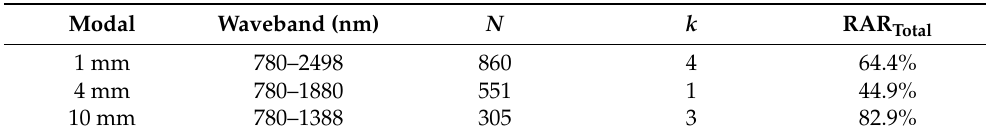
Table 1. Modeling discrimination effects of kNN models of three measurement modals based on desaturated wavebands.